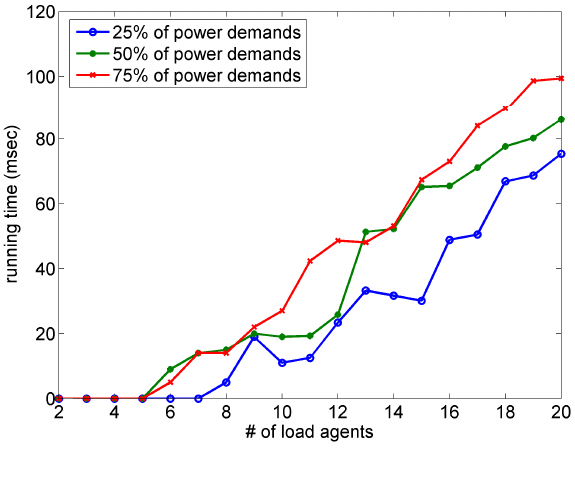
Figure 11. The running time of our load-shedding system with varying the number of